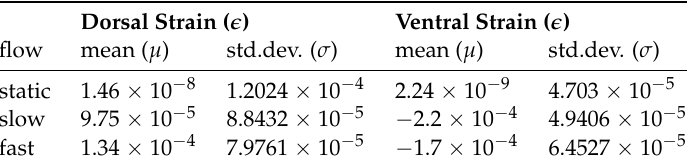
Table 1. Statistics (means, standard deviations) of strain measured on dorsal and ventral gages of the rostrum during horizontal placement in three flows are calculated over 96,000 measurements encompassing the full duration of each of the five minute tests, respectively.